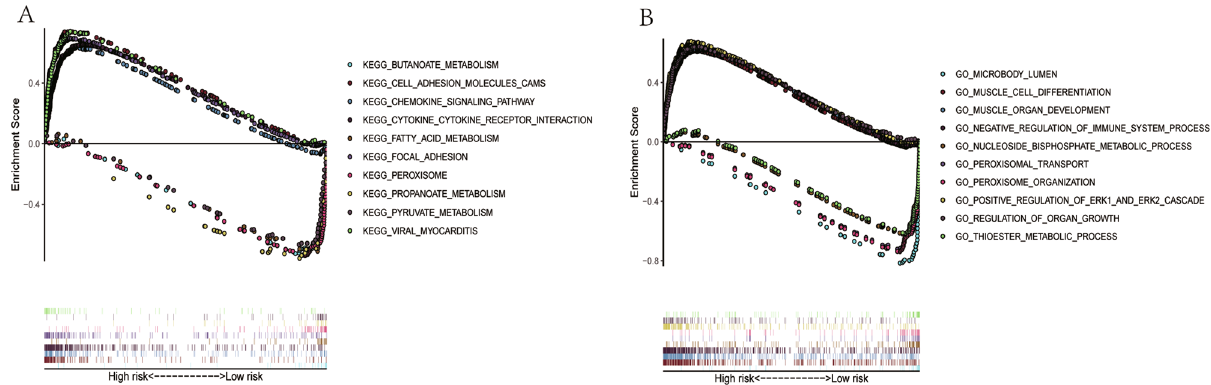
Figure 9. KEGG pathways and GO enrichment analyses by GSEA. ( A ) Top 10 representative KEGG pathways. ( B ) Top 10 representative GO